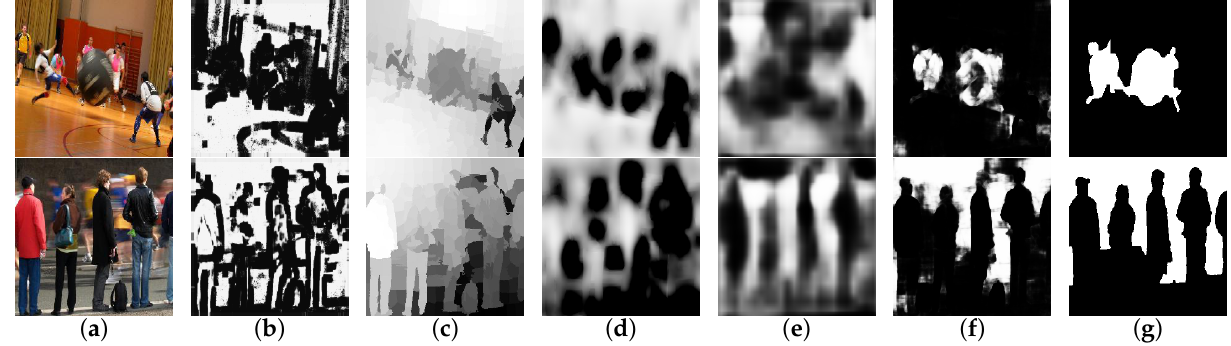
Figure 4. Motion blur maps generated using different methods. In the visual comparison, our method performed better than the other